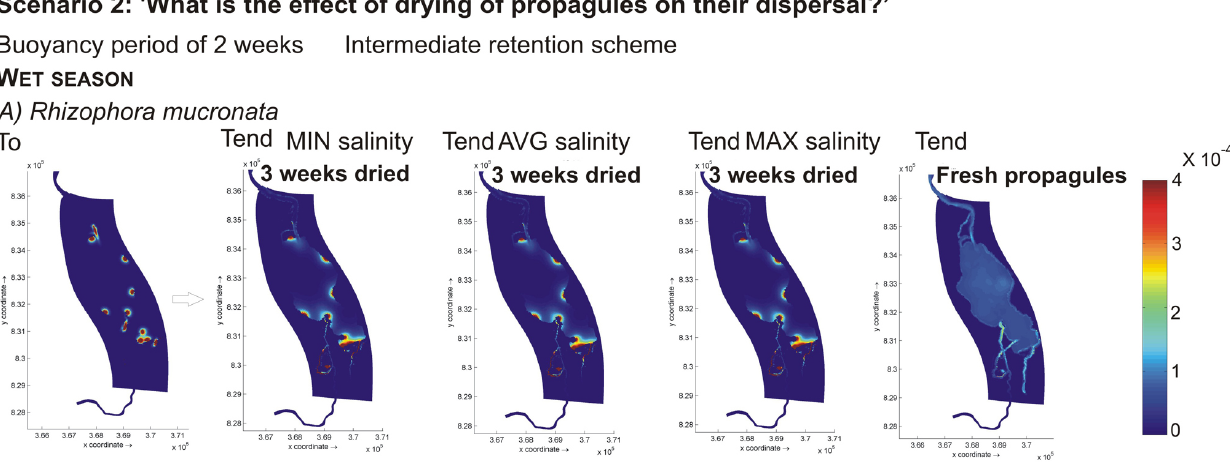
Fig. 6a. Results of scenario 2 (effect of drying) showing the distribution plots of Rhizophora mucronata in the wet season. Red, yellow and light blue colours indicate a high, medium and low concentration of propagules respectively.